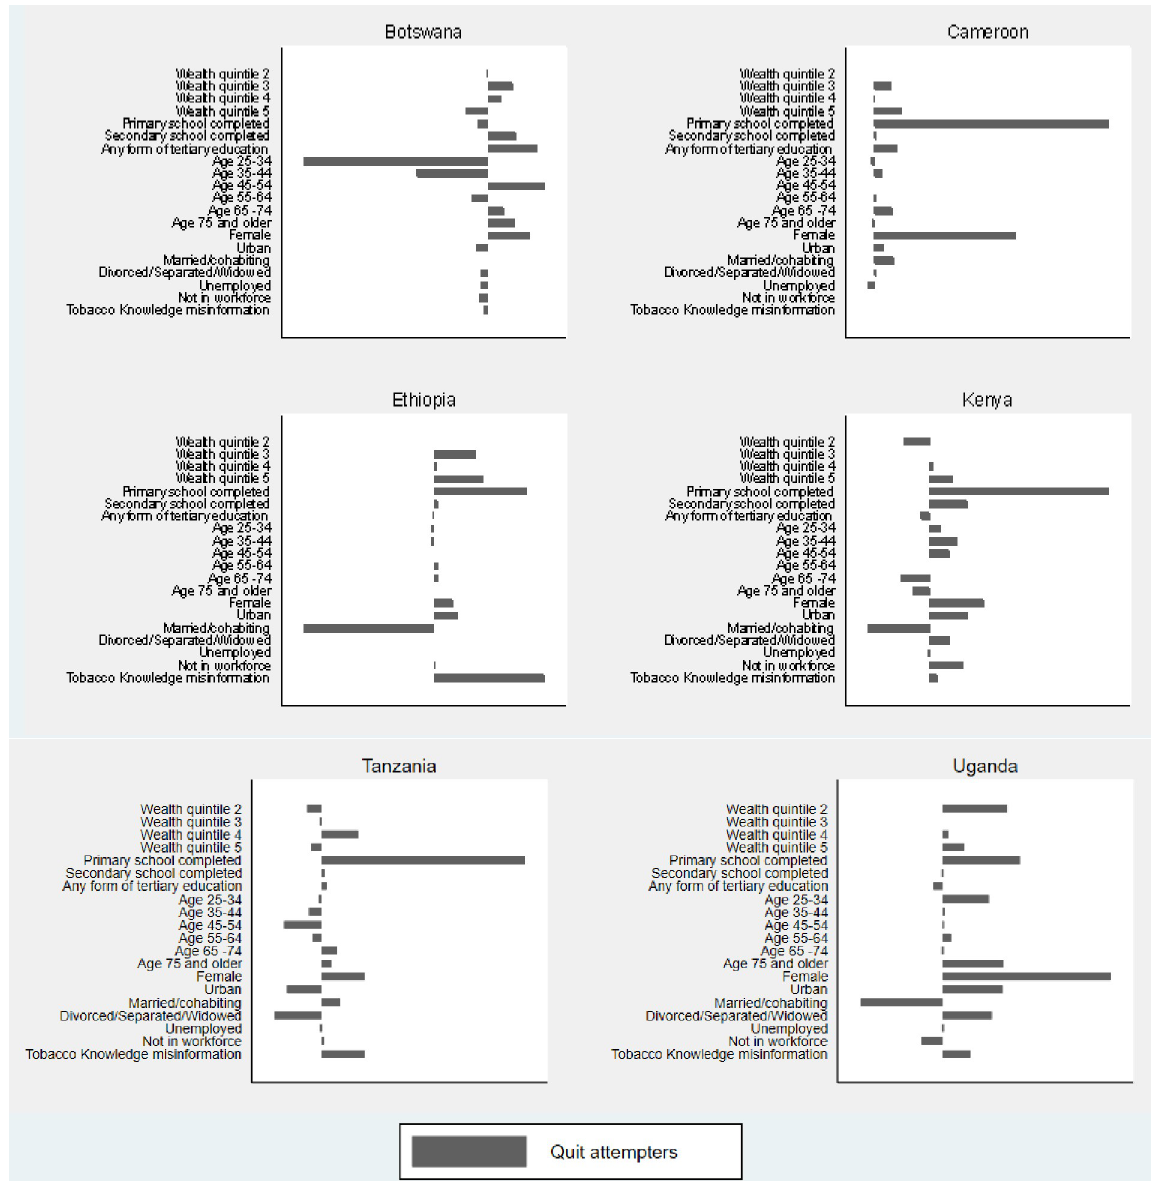
Fig 4. Percentage contribution of x in to education-related inequalities in TC